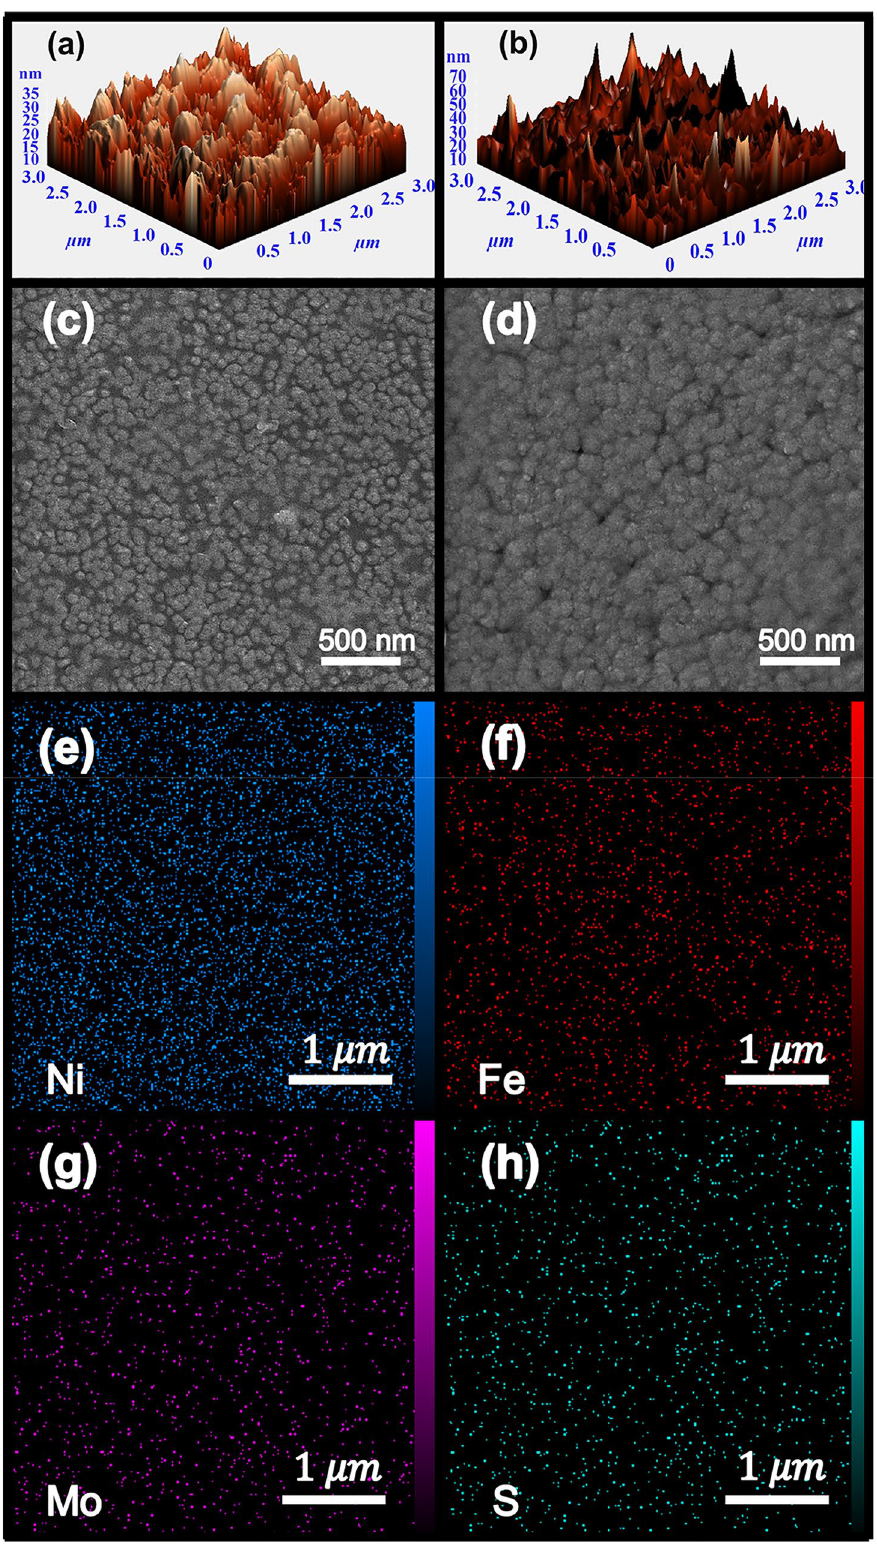
Figure 2. AFM measurement of ( a ) Py and ( b ) MoS 2 @Py samples. The FESEM images of ( c ) Py and ( d ) MoS 2 @ Py samples. ( e ) and ( f ) are the EDX mapping of Py sample and ( g ) and ( h ) the EDX mapping of the MoS 2 @Py